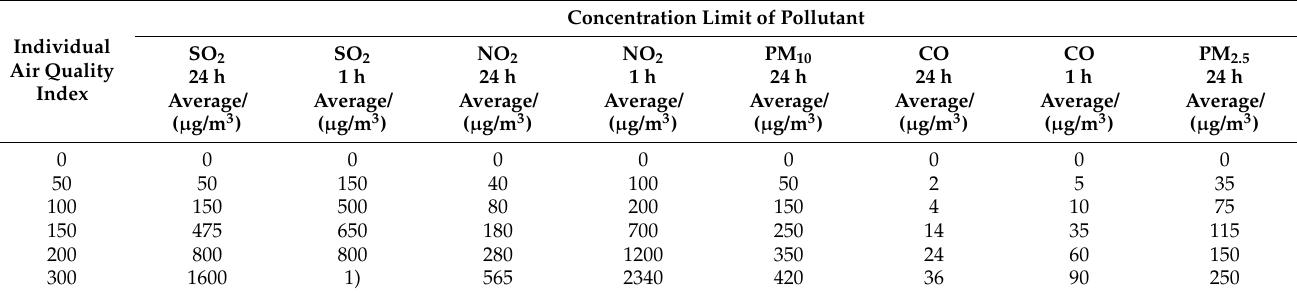
Table 10. Concentration limit of pollutants corresponding to